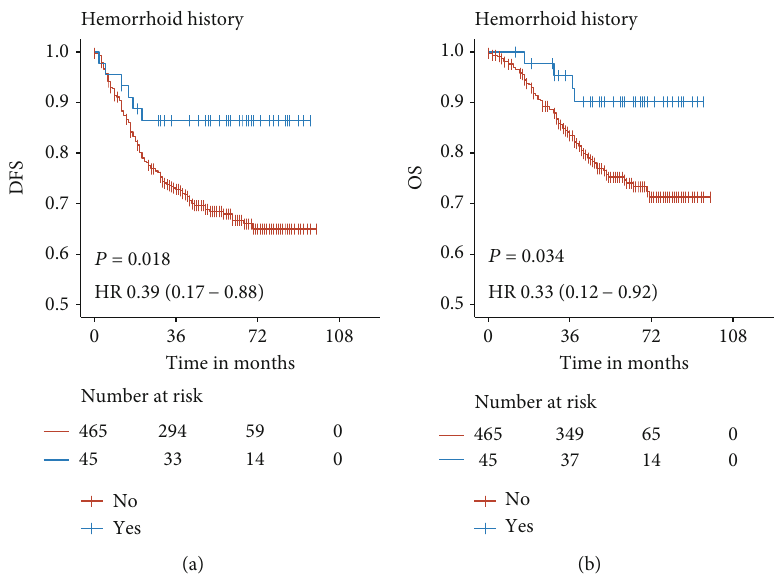
Figure 2: Kaplan – Meier survival curves of rectal cancer patients with or without hemorrhoid history. The curves showed signi fi cantly higher DFS (a) and OS (b) outcomes in the hemorrhoid group compared to the nonhemorrhoid group. Log-rank test P values and hazard ratios (HRs) with 95% CI are given in each plot. DFS: disease-free survival; OS: overall